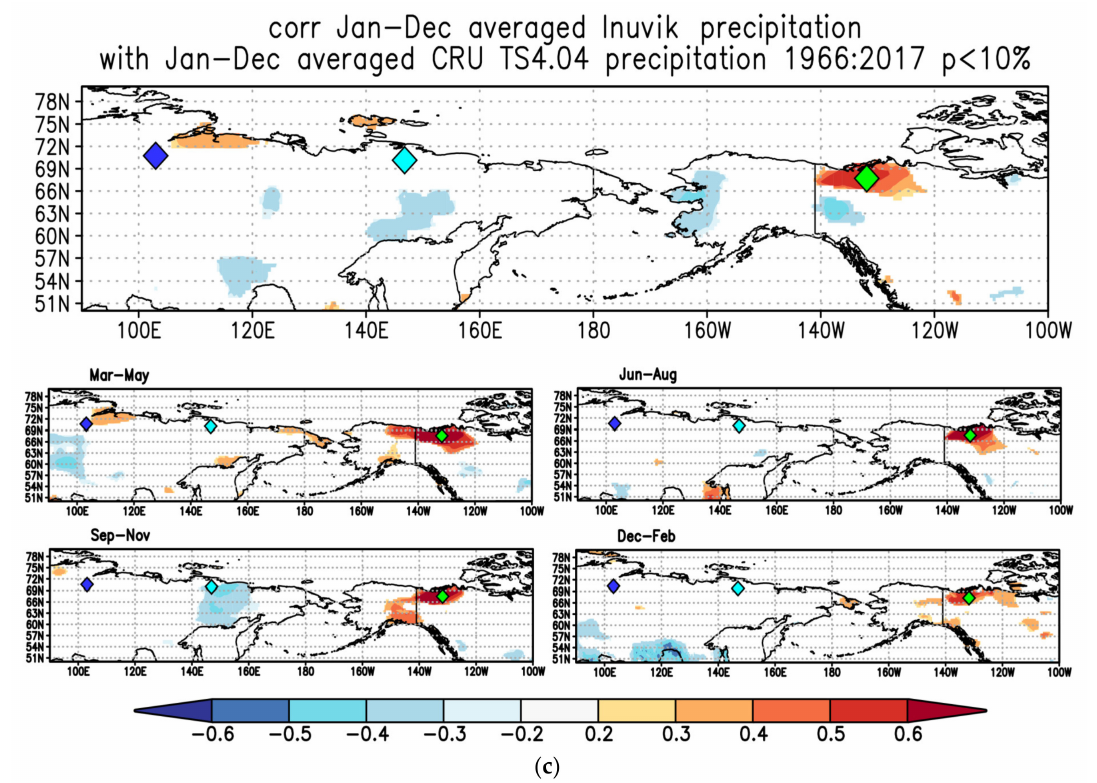
Figure 4. Spatial distribution of correlation coefficients between gridded (51 ◦ N–78 ◦ N 90 ◦ E–100 ◦ W) and local annual (January-December), spring (March-April-May), summer (June-July-August), autumn (September-October-November) and winter (December-January-February) precipitation for ( a ) Chokurdakh, northeastern Yakutia (YAK), ( b ) Khatanga, eastern Taimyr (TAY) and ( c ) the Mackenzie Delta, Canada (CAN) for the period from 1966 to 2017. Negative significant correlation coefficients are marked in dark blue (r ≥ − 0.6; p < 0.01), while positive significant correlations are highlighted in red (r ≥ 0.6, p < 0.01).